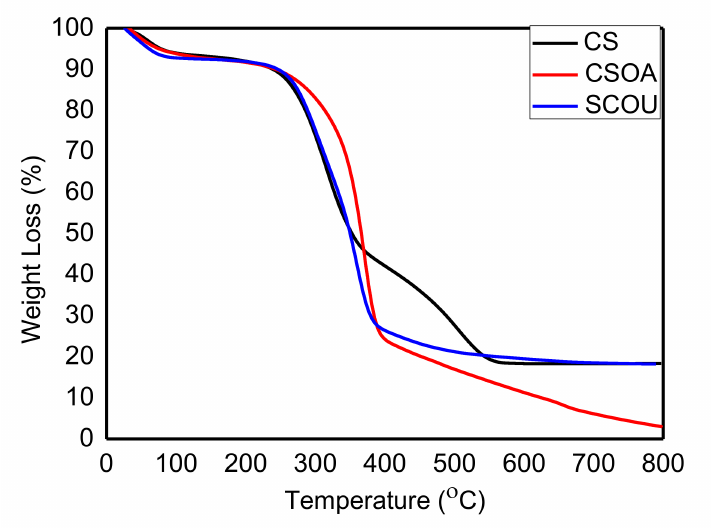
Figure 5. TGA of CS before and after physico-chemical